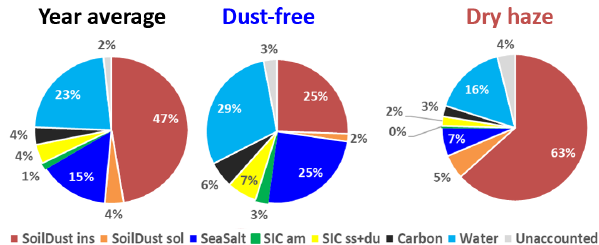
Figure 5. IMB obtained by attributing the calculated water content to the respective source classes for the entire campaign and the dust- free and dry-haze seasons. Values are in µgm − 3 and percentage of measured total mass.